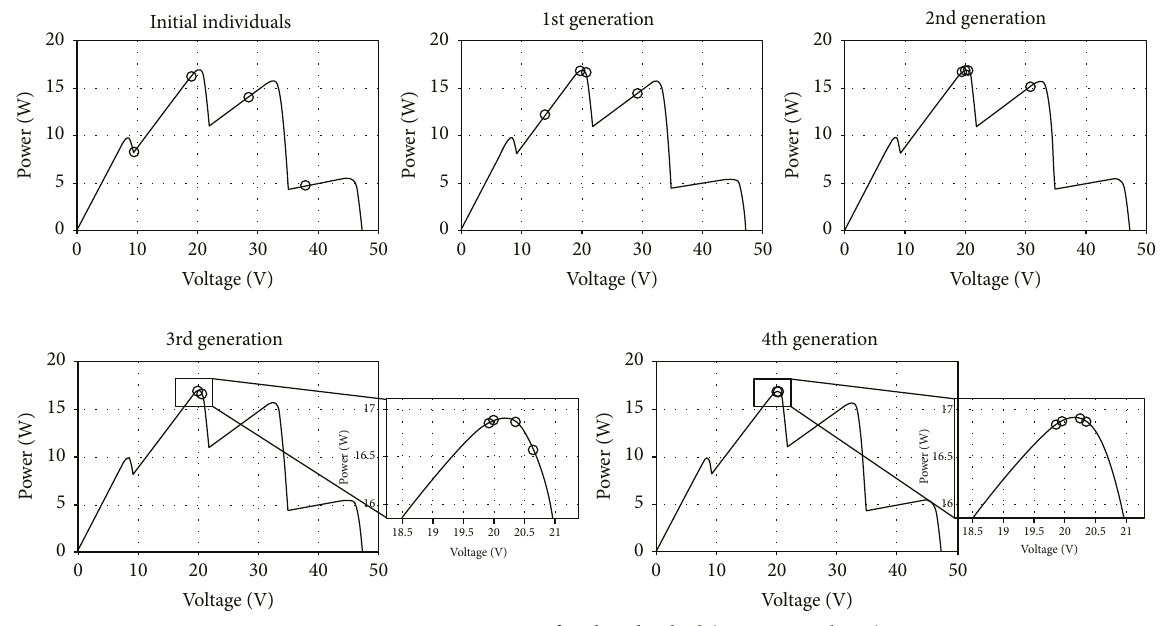
Figure 8: Position variation of each individual (pattern number 9). Table 3: Simulation results of GA with di ff erent population Table 6: Simulation results of the proposed algorithm with di ff erent numbers under uniform irradiance. population numbers under PSCs.